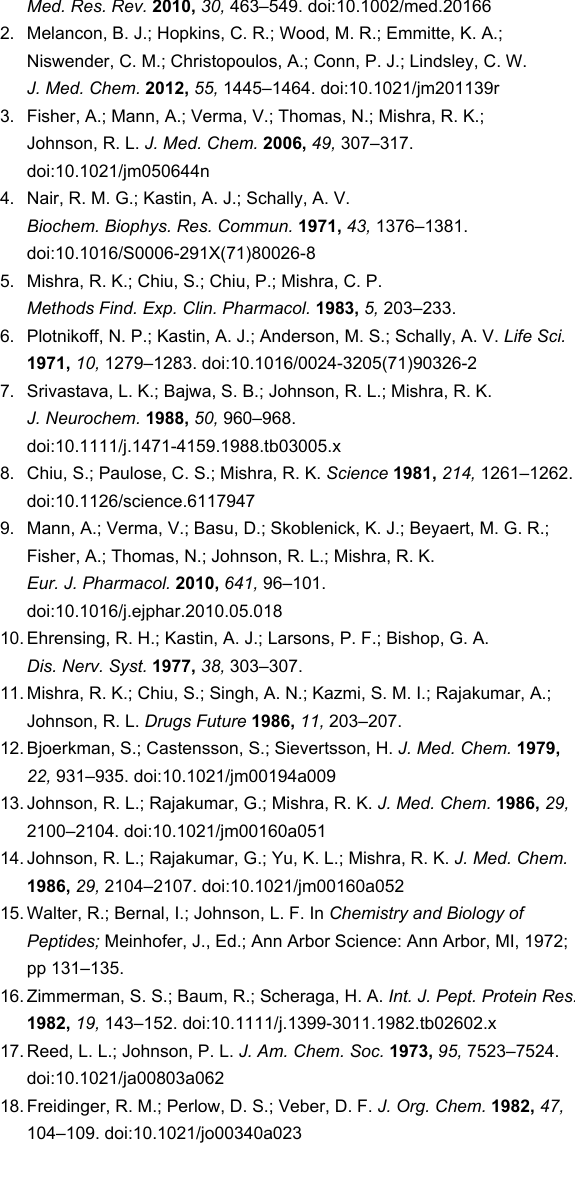
Figure 8: Positive and negative allosteric modulators of the D 2 dopamine receptor based on the 5.6.5 spiro-bicyclic scaffold.